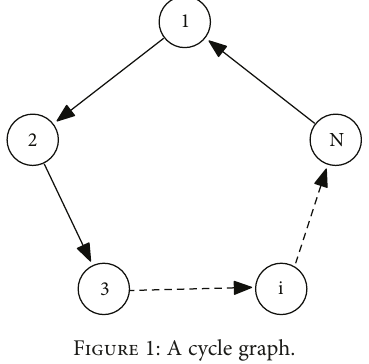
Figure 1: A cycle